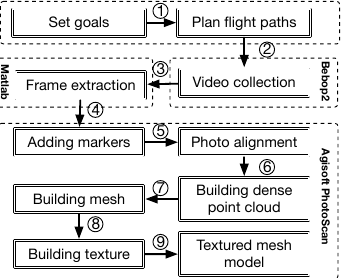
Figure 4. Our workflow for flying QUAV for 3D indoor reconstruction.